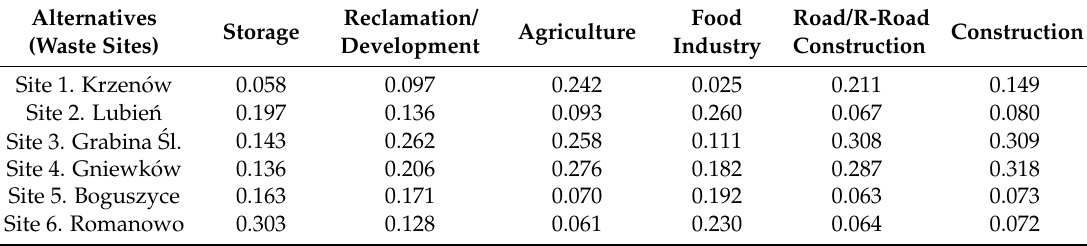
Table 3. Weights of local preferences with respect to potential waste uses